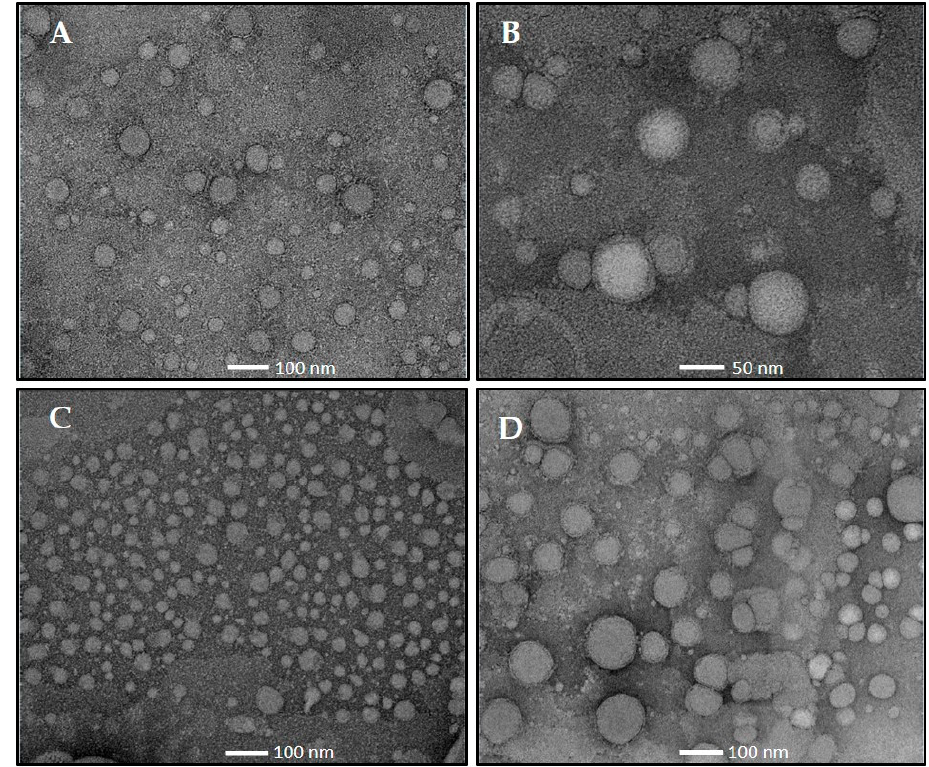
Figure 2. TEM images of ( A , B ) bilosomes and ( C , D ) the bilosomes surface-modified with Pluronic 123 (respectively, samples 4 and 7 in Table (respectively, samples 4 and 7 in Table 1).